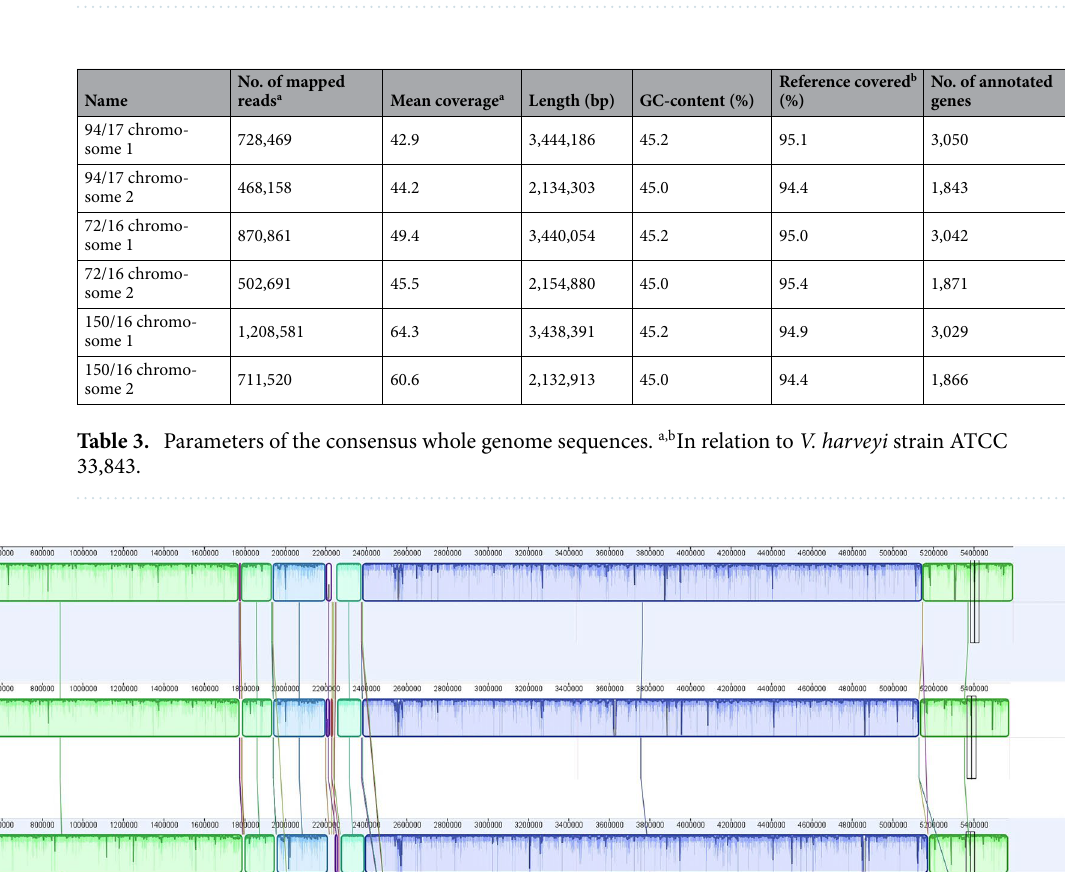
Table 2. Susceptibility of V . harveyi strains to antibacterial substances. *Numbers represent the diameter of the inhibition zones in mm.